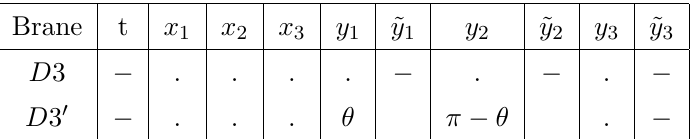
Table 1 . D3-brane con(cid:12)guration: Neumann and Dirichlet directions are lines and dots respectively. The angle is taken with respect to the non tilded y